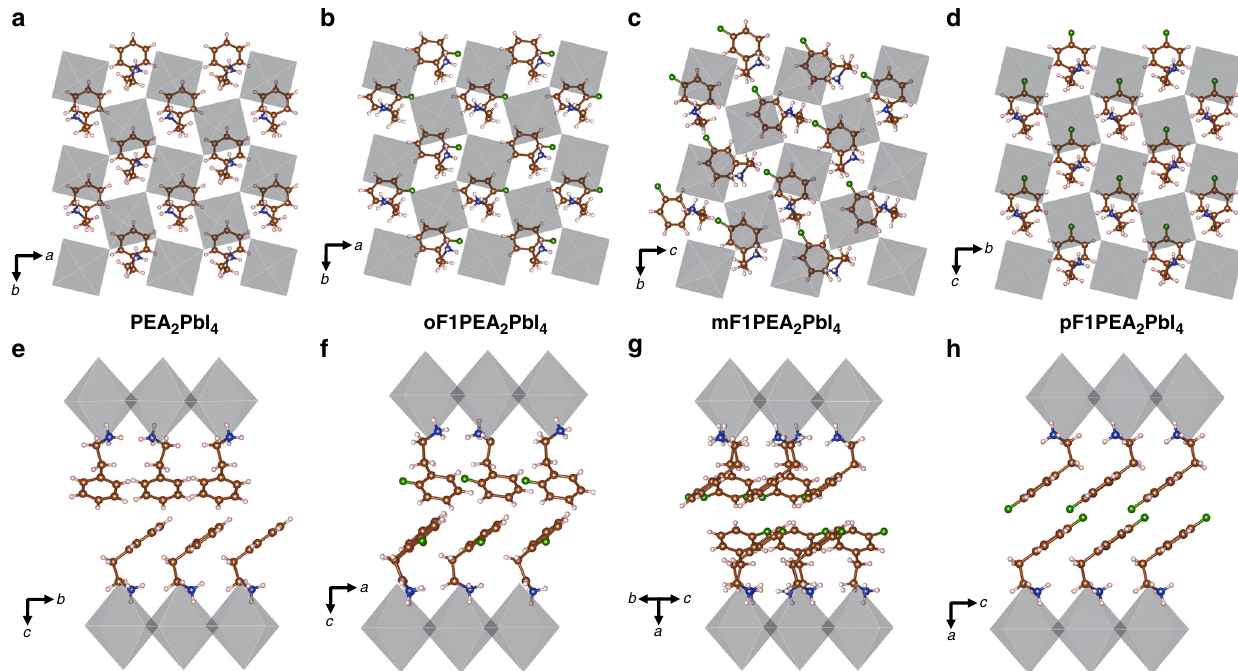
Fig. 5 Single crystal structures of 2D OIHPs ( n = 1) with different cations: Idealized crystal structures showing the different ordering of organic cations within a single layer for PEA ( a ) (this structure was redrawn based on the work reported by Du et al.) 38 , oF1PEA ( b ), mF1PEA ( c ), and pF1PEA ( d ). Idealized crystal structures showing the different packing arrangements within the organic interlayer gallery for PEA ( e ), oF1PEA ( f ), mF1PEA ( g ), and pF1PEA ( h